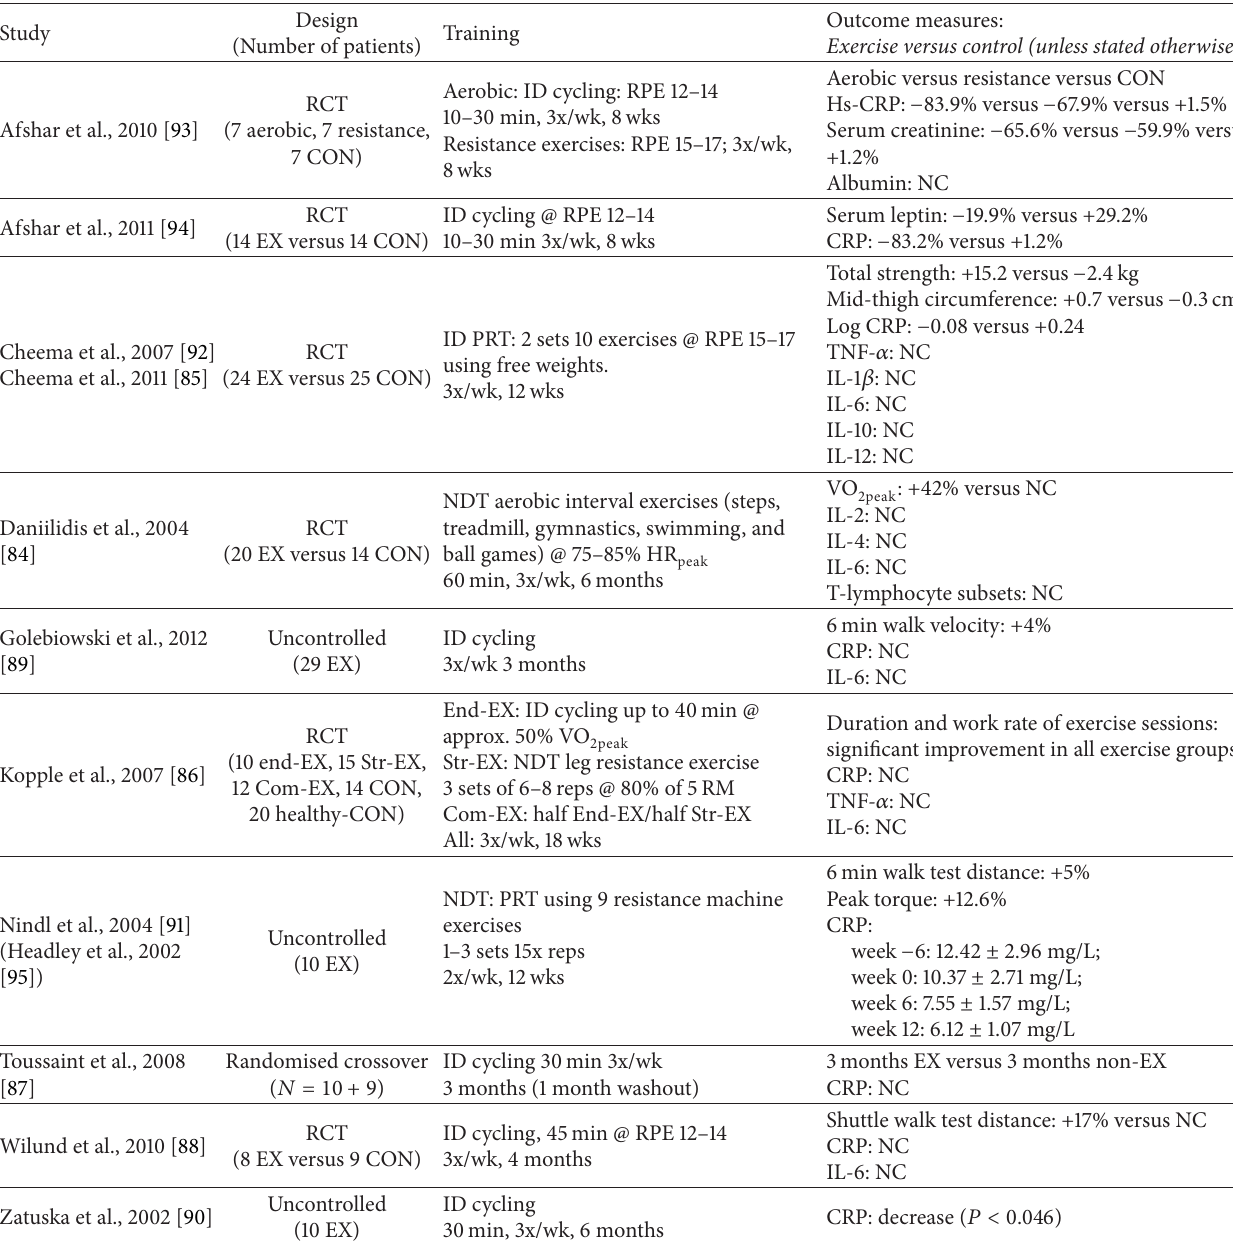
Table 3: Exercise intervention studies in haemodialysis